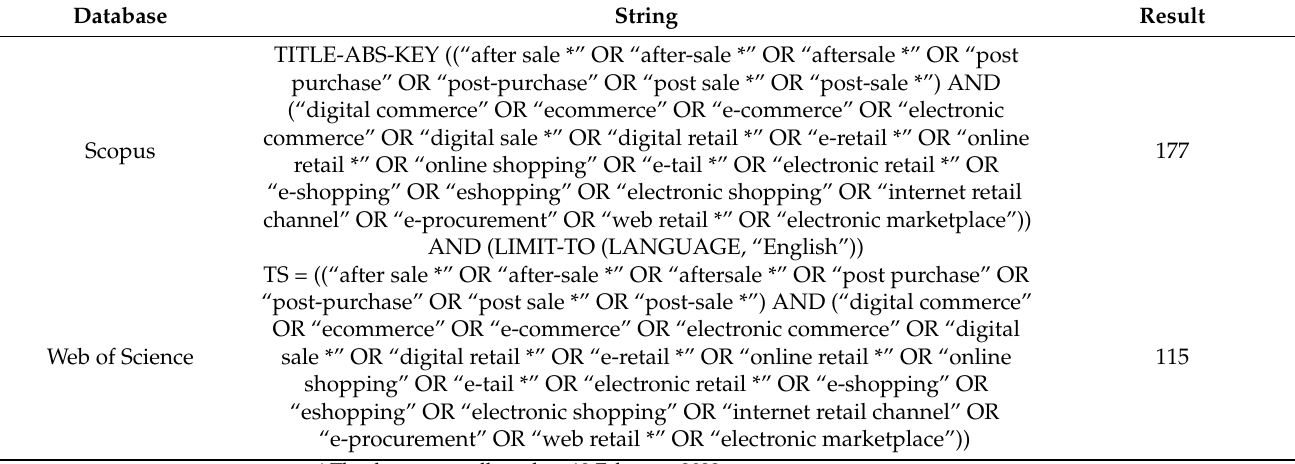
Table 1. Summary of criteria used for the systematic review. Database String